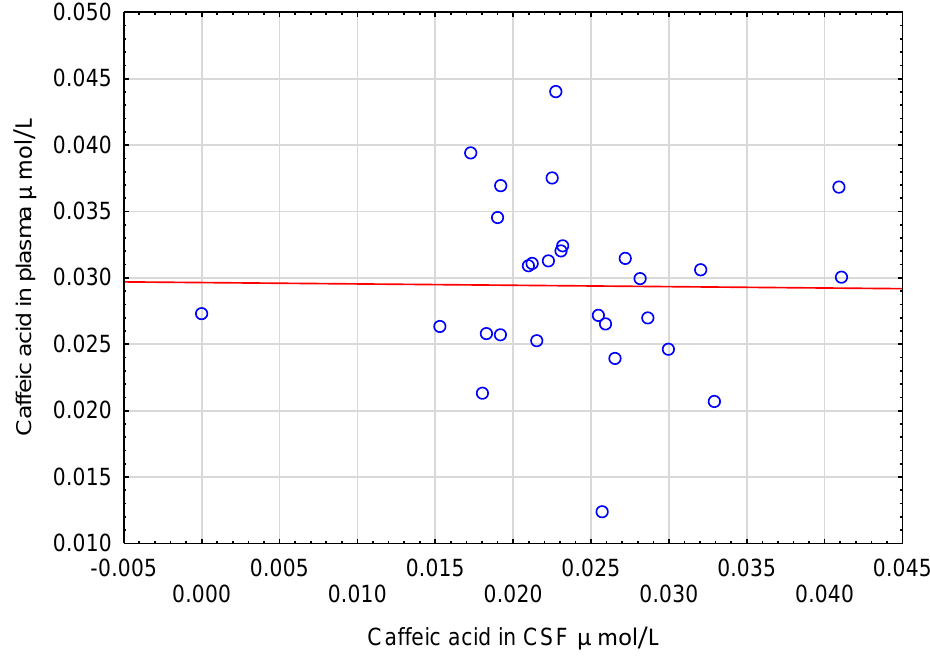
Figure 4. Scatter plot of caffeic acid concentrations in plasma (Y) and cerebrospinal fluid (X). No significant correlation was found between these two variables (ρ = −0.109, p = 0.58, n = 28).